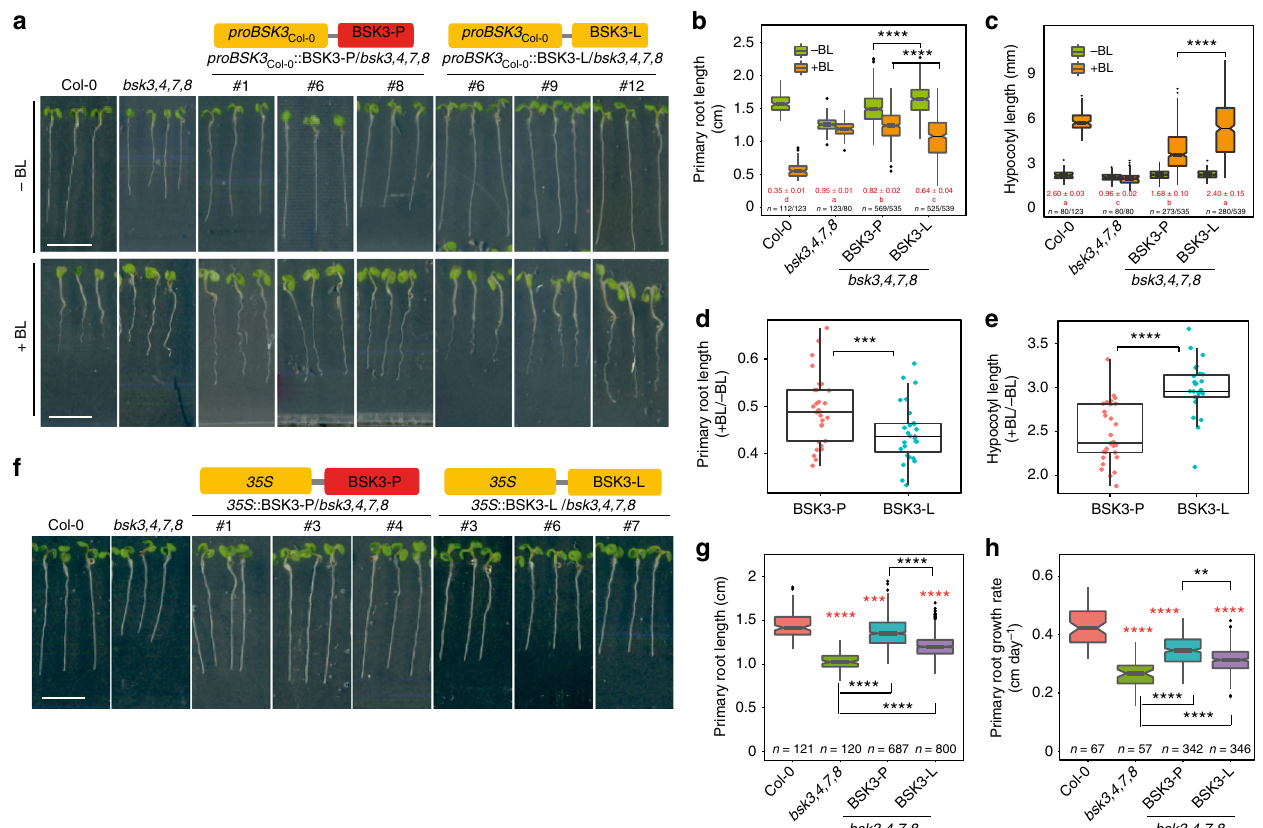
Fig. 4 Allelic variation of BSK3 determines plant sensitivity to BR. a – c Brassinosteroid sensitivity of wild-type (Col-0), bsk3 , 4 , 7 , 8 , and independent transgenic lines expressing sequences coding for either the BSK3-P or BSK3-L variant under the control of the BSK3 Col-0 promoter. Appearance ( a ), primary root length ( b ), and hypocotyl length ( c ) of 6-day-old plants. Numbers in red indicate relative root or hypocotyl length ( + BL/ − BL). Different letters indicate signi fi cant differences for relative root or hypocotyl length at P < 0.05 according to one-way ANOVA and post-hoc Tukey ’ s test. d , e Primary root ( d ) and hypocotyl ( e ) growth responses of natural accessions carrying BSK3-P or BSK3-L to the exogenous supply of 1 µ M 24-epibrassinolide ( n = 29 and 27 accessions for P and L haplotypes, respectively). f – h Root growth of wild-type (Col-0), bsk3 , 4 , 7 , 8 , and independent transgenic lines expressing sequences coding for either the BSK3-P or BSK3-L variant under the control of the CaMV 35 S promoter. Appearance ( f ), primary root length ( g ), and root growth rate ( h ) of 6-day-old plants. Horizontal lines show medians; box limits indicate the 25th and 75th percentiles; whiskers extend to 5th and 95th percentiles. Asterisks indicate statistically signi fi cant differences to wild-type (in red) or to bsk3 , 4 , 7 , 8 (in black), or between two BSK3 protein haplotypes (in black) according to Welch ’ s t -test (** P < 0.01; *** P < 0.001; **** P < 0.0001). Scale bars, 1 N de fi ciency promotes BR signaling by upregulating BAK1 . In Arabidopsis, BSK3 mediates BR signaling downstream of the BR